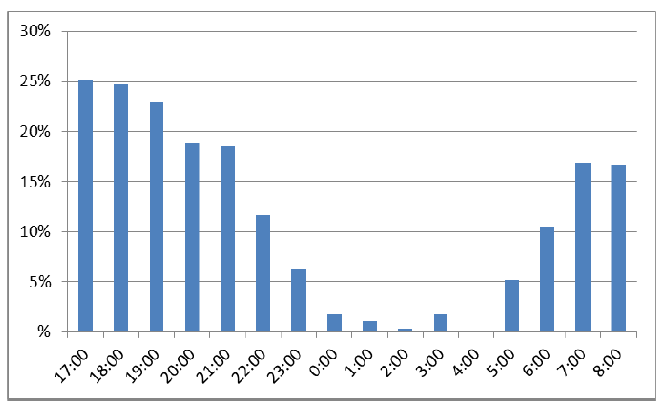
Figure 13. Distribution of pedestrian flow per